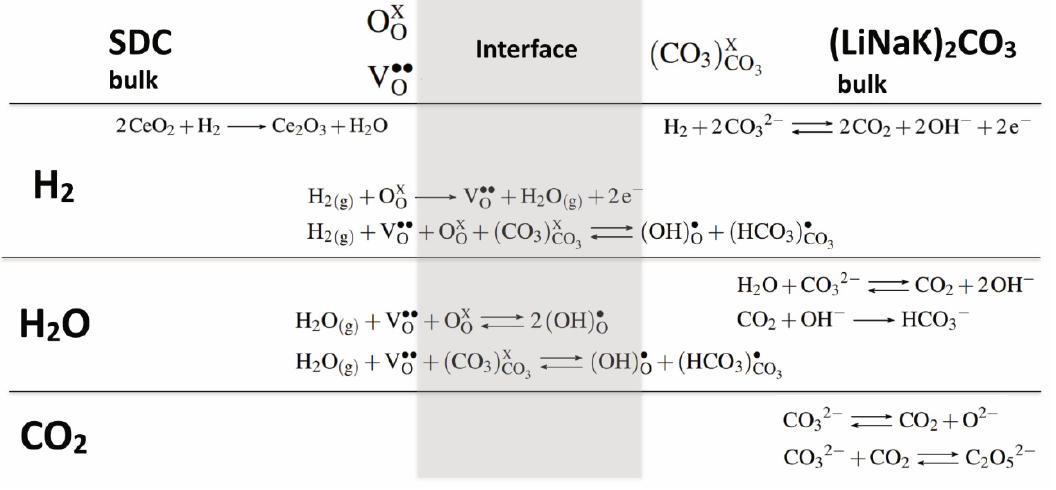
Figure 10. Summary of the mechanistic model for the transport mechanisms and phenomena at the solid oxide/molten carbonate interface.